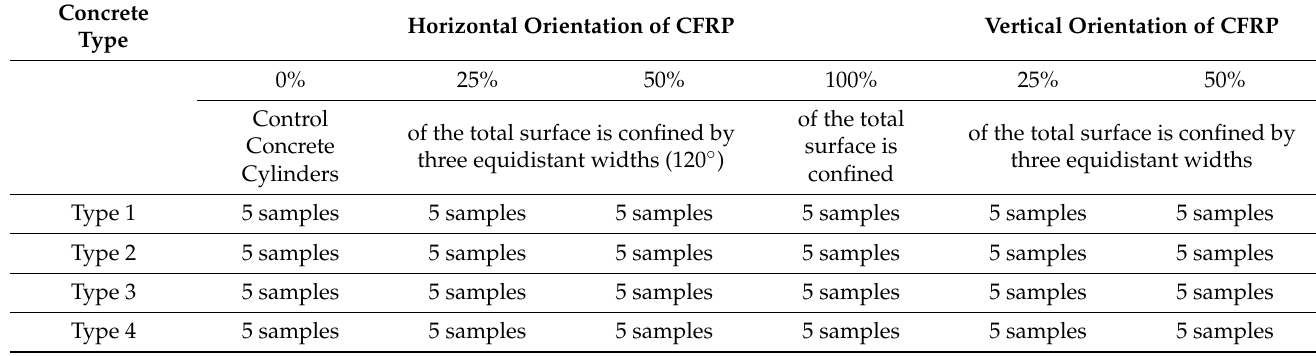
Table 5. Percentages of CFRP wraps used as compared to the cylinder’s surface total.